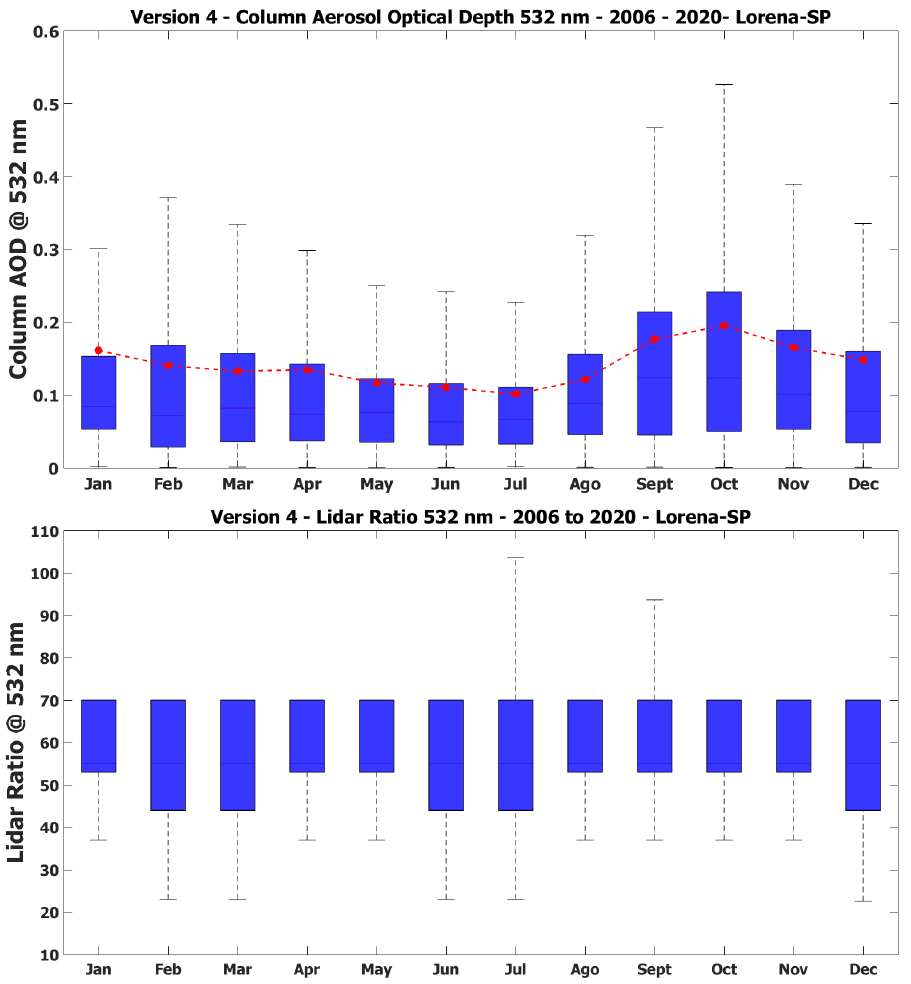
Figure 4. Whisker plots of the monthly AOD and lidar ratio from CALIOP/CALIPSO products at 532 nm over Lorena-SP, for the period of June of 2006 to December of